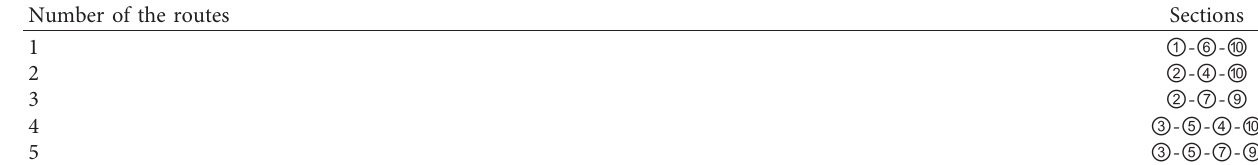
Table 3: Routes shown in the experiment